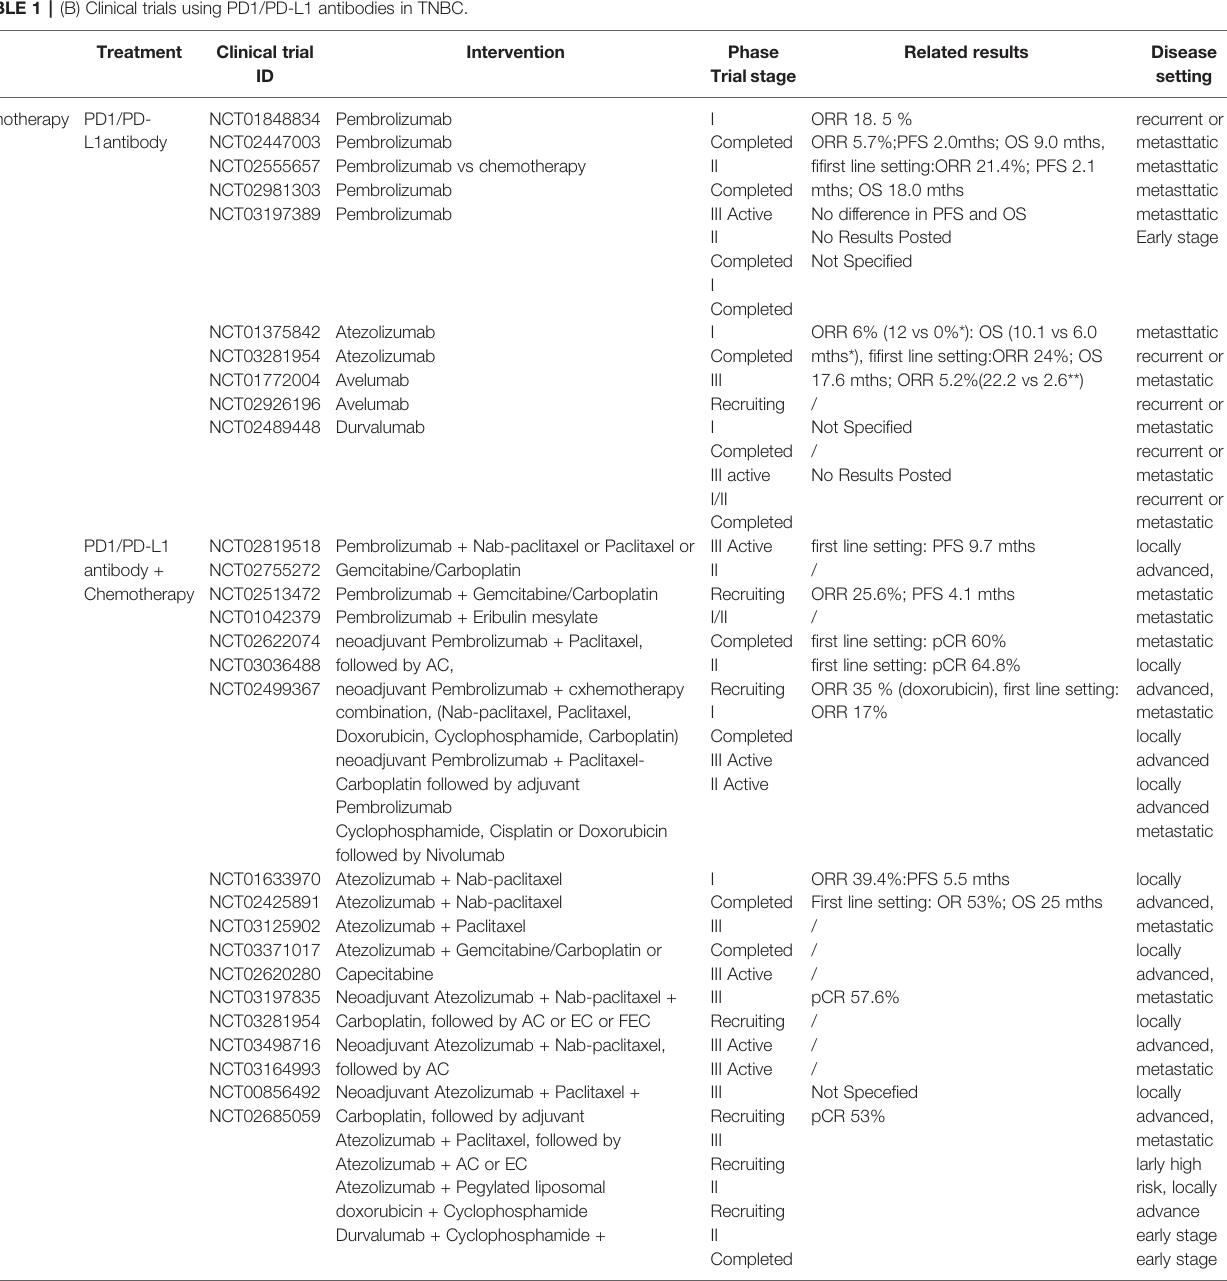
TABLE 1 | (B) Clinical trials using PD1/PD-L1 antibodies in TNBC.